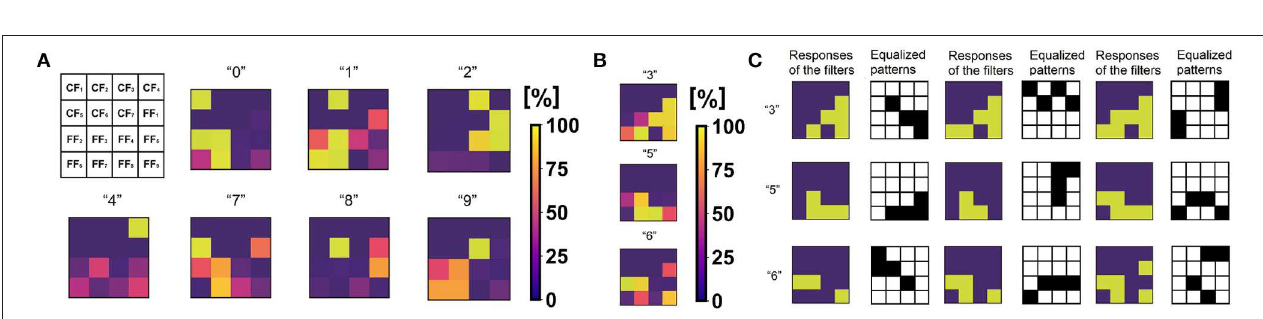
FIGURE 3 | Implemented combinational logic for equalizing the responses coming from the convolution between the input image and the filters. Every bus line has been associated with a certain equalized pattern. Note that the class filters have higher priority respect to the feature filters, which are selected only if all the class filters give a GND response. In this way, the trained classes are univocally selected by their own class filter.